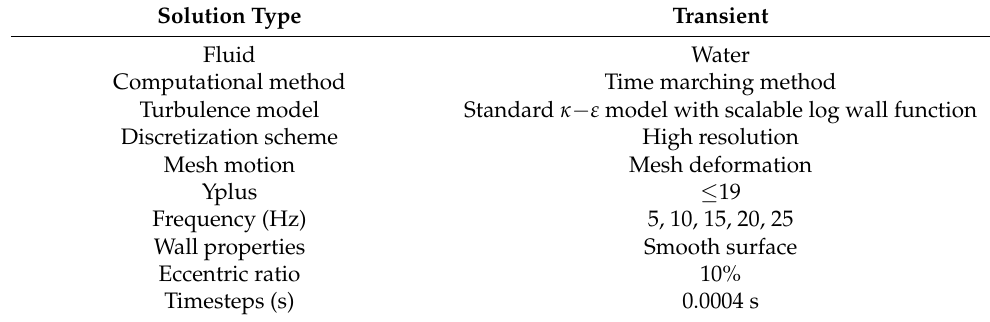
Table 3. Numerical parameter settings.